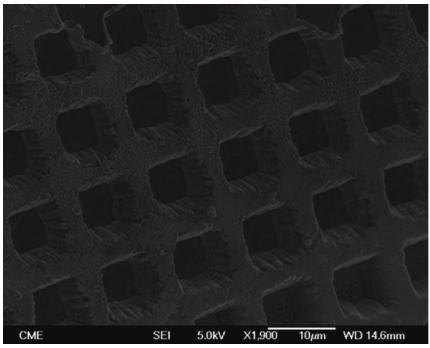
Figure 2: Scanning electron microscope image of a 3D photonic structure made by the new fabrication process